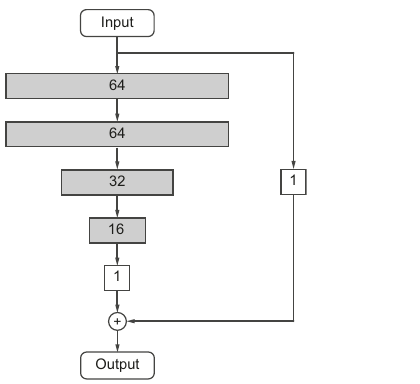
Fig. 5 DeepNull DNN model architecture. Each rectangle represents one layer and all layers are fully connected. Shaded layers use the ReLU activation and the non-shaded layers do not use an activation function (i.e. linear connection). The input is the set of known covariates and the output is the predicted